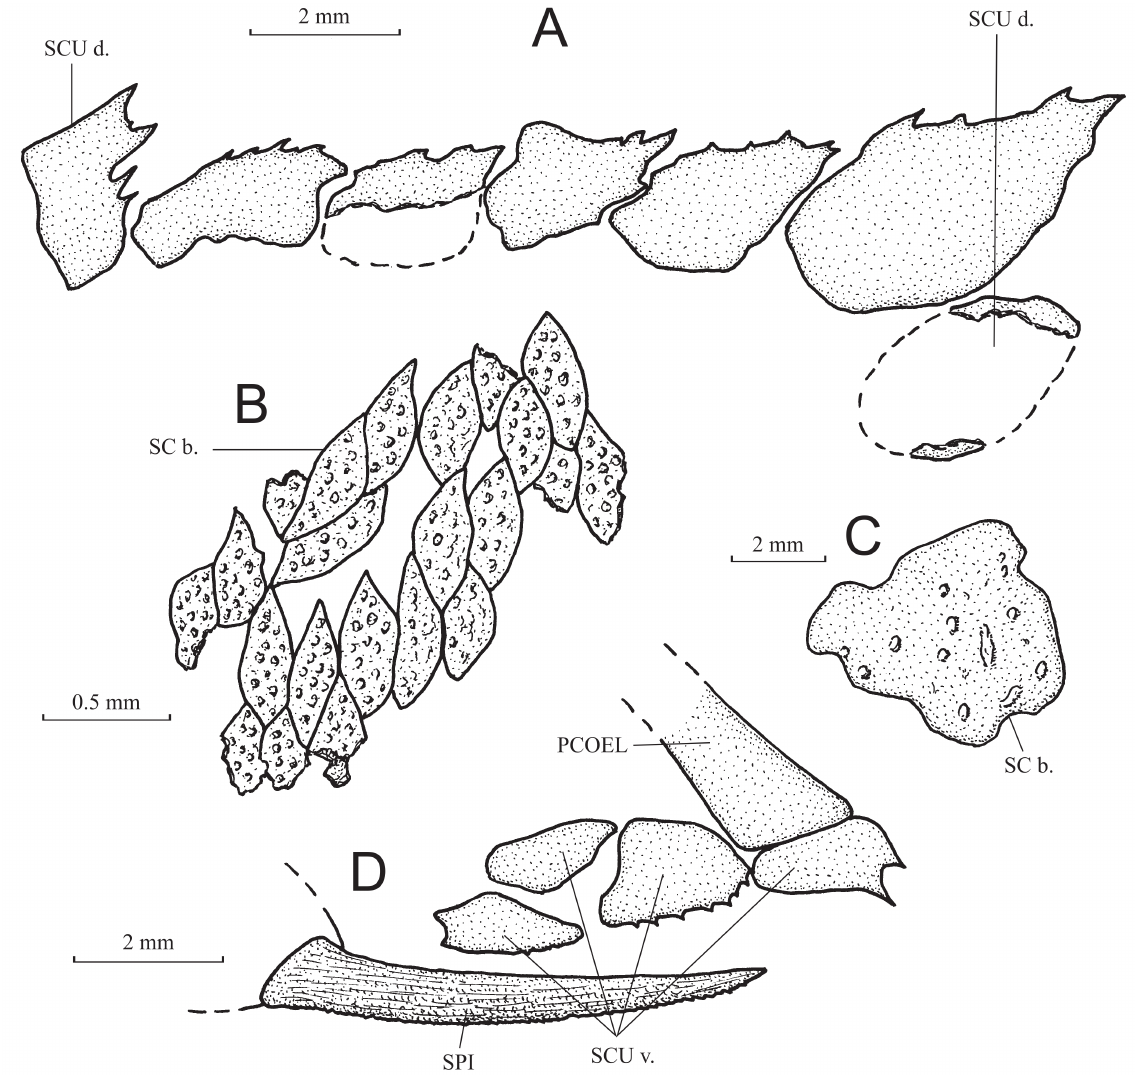
Fig. 11. Joinvillichthys lindstroemi (Davis, 1890). A . Dorsal ridge scutes of sample IRSNB N° P 9276. B . Anterior flake-like body scales of sample CLC S-138. C . Posterior scute-like body scale of sample CLC S-138. D . Ventral keel scutes of sample CLC